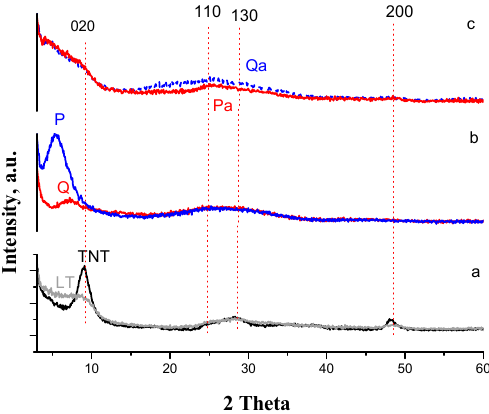
Figure 2. X-ray diffraction patterns of the photocatalysts analyzed. ( a ) TiO 2 powders and nanotubes without sensitizers; ( b ) TiO 2 powders sensitized and ( c ) TiO 2 nanotubes sensitized.